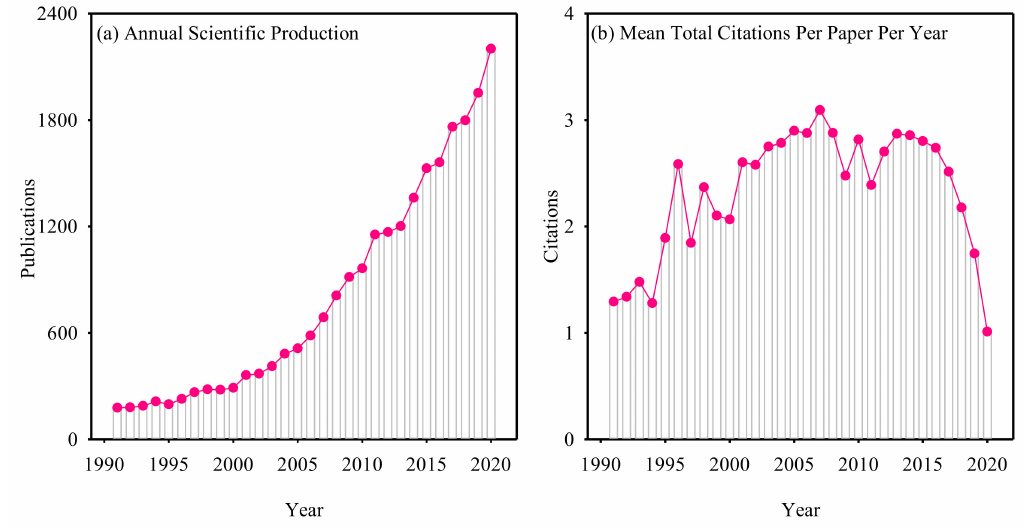
Figure 1. Annual scientific production of publications on seed traits study ( a ) and mean number of citations per paper per year ( b ) from 1991 to